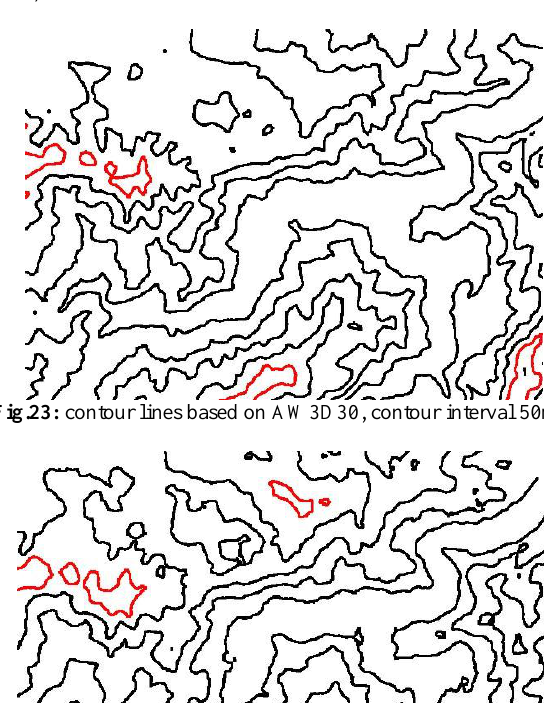
Fig.22: contour lines based on WorldDEM, contour interval 50m, covered area ~ 6km x 5km